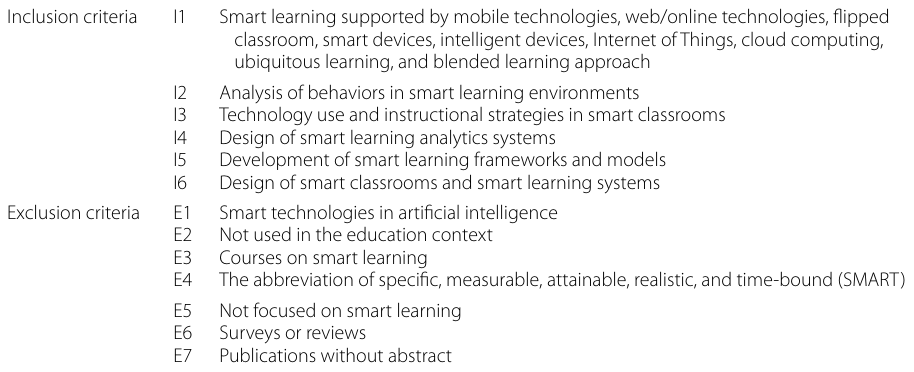
Table 1 Inclusion and exclusion criteria for data screening Inclusion